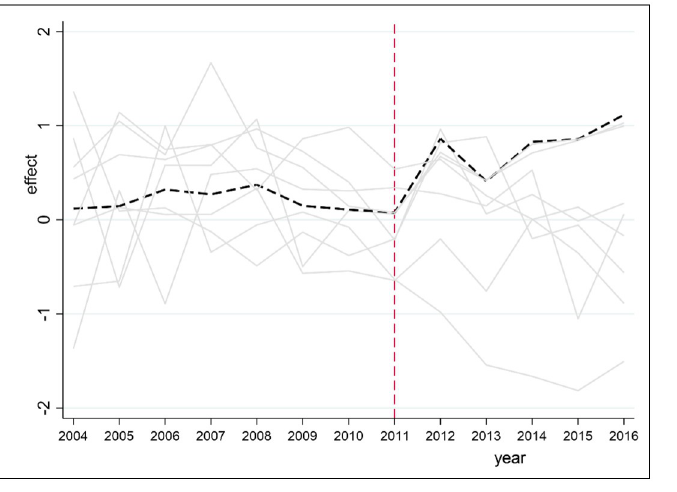
Fig 8. Prediction error distribution of COD for Hefei.